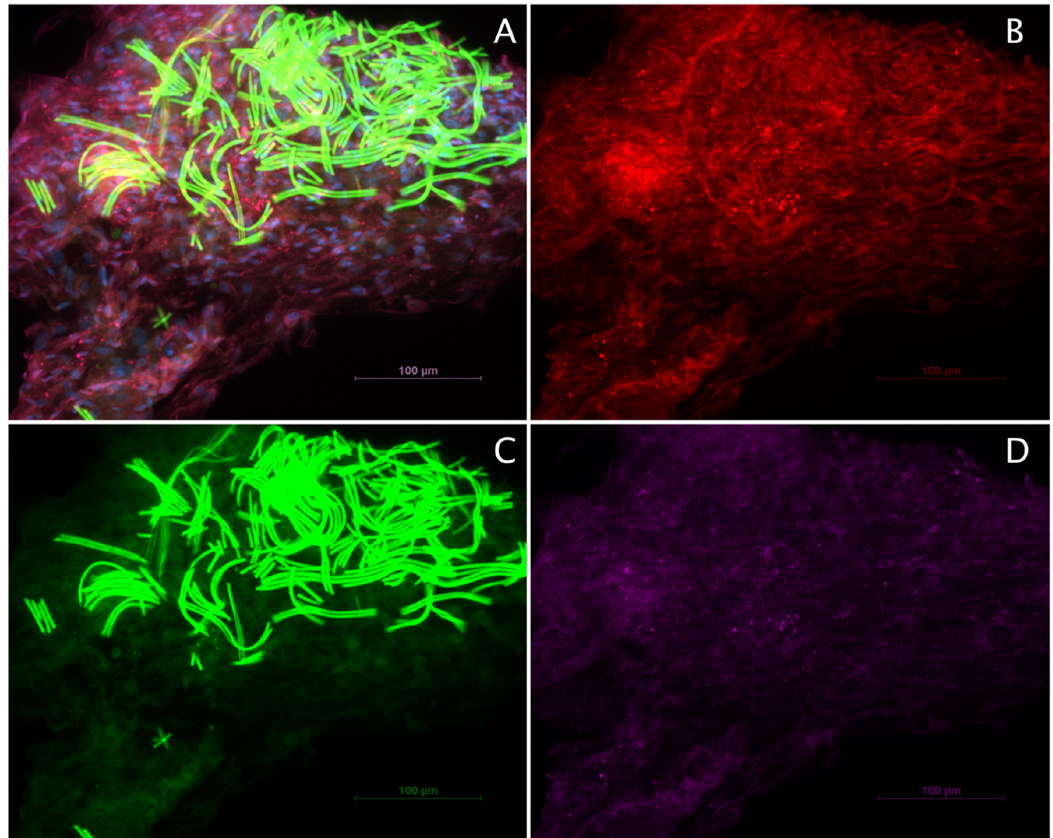
Figure 6. Characterization of Schwann cells and ADSC co-cultures on spider silk by immunohistochemistry. Scale bars in ( A – D ) represent 100 µm: ( A ) Representative image of paraffin sections stained for the characteristic Schwann cell marker S-100 (red), ADSC marker CD 90 (green), vimentin (purple), and DAPI (blue); ( B ) S-100 staining; ( C ) CD90 staining with strong autofluorescence of the spider silk fibers; and ( D ) vimentin staining.